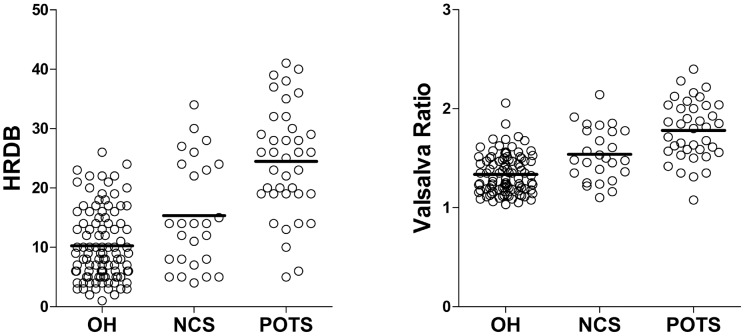
Results of heart rate response to deep breathing and Valsalva ratio.Orthostatic hypotension (OH) patients showed the smallest values in both heart rate response to deep breathing (HRDB; 10.3±6.0 beats/min) and Valsalva ratio (1.34±0.20) and postural orthostatic tachycardia syndrome (POTS) patients showed the largest values in both HRDB (24.5±9.2 beats/min) and Valsalva ratio (1.78±0.30). Neurocardiogenic syncope (NCS) patients showed intermediate levels of HRDB (15.4±9.1 beats/min) and Valsalva ratio (1.54±0.20) compared with OH and POTS patients.